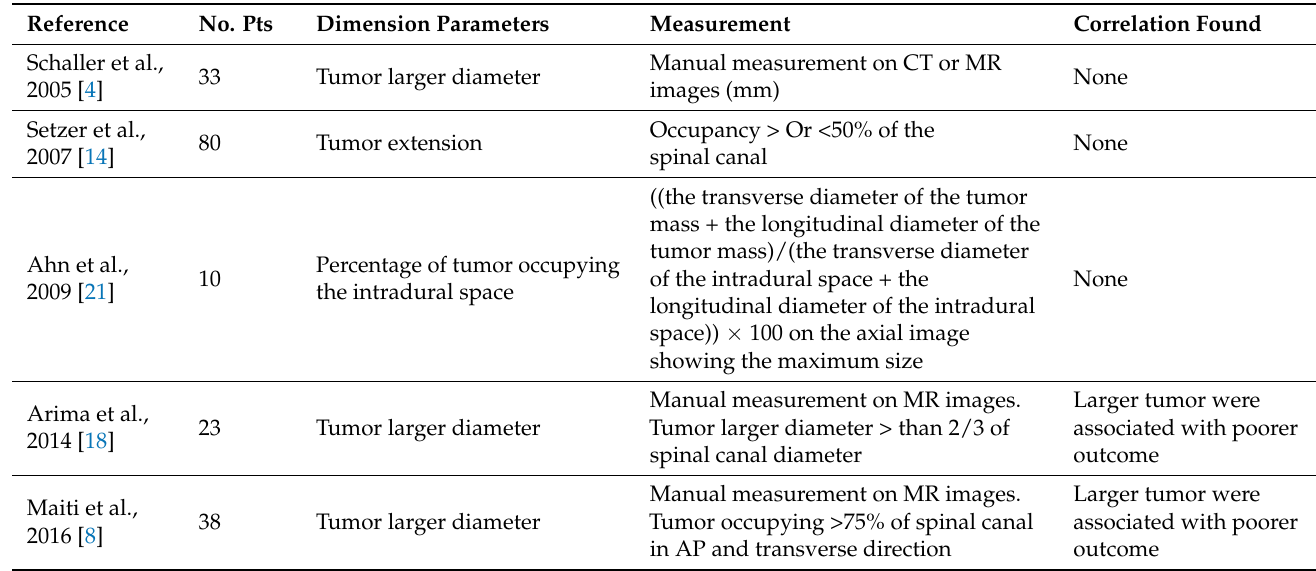
Table 1. Review of the previous literature. Parameters and formulas are reported as indicated in materials and method section of the respectively